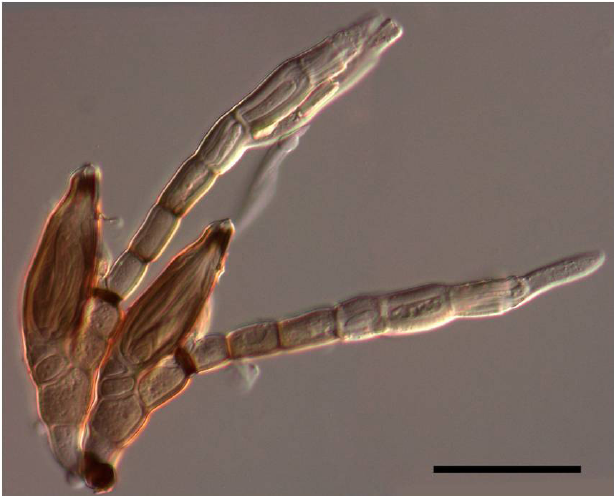
Fig 1 . Laboulbenia camponoti Batra. SENEGAL: Kaolack, road between Birkelane and Kaffrine. Two mature thalli showing the black foot, the perithecium with spores, and the elongated appendages. Scale: 50 μm.